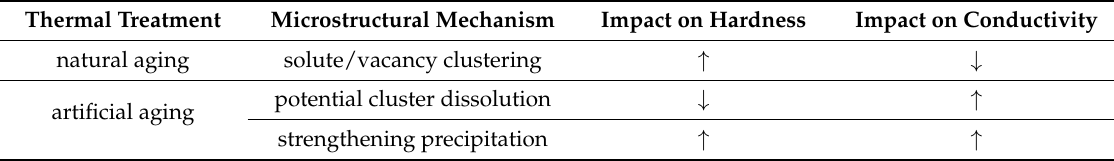
Table 2. General structural evolution during aging in Al-Mg-Si alloys, and the resulting impact on hardness and conductivity .